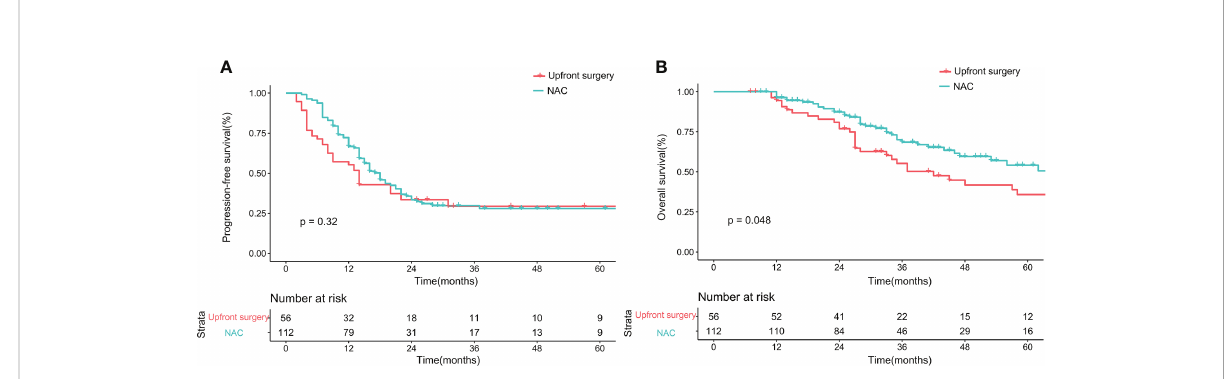
FIGURE 2 Kaplan-Meier curves for progression-free survival (A) and overall survival (B) between upfront surgery and neoadjuvant chemotherapy groups after 1:2 Propensity Score Matching Analysis. NAC, neoadjuvant